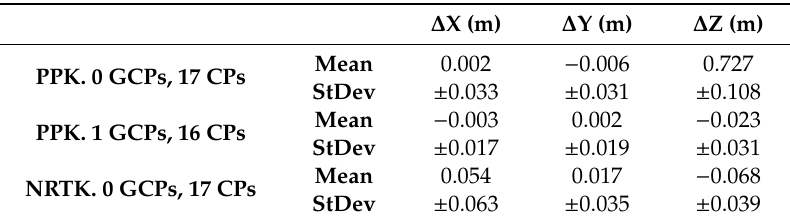
Table 2. Positional accuracy of the di ff erent direct georeferencing strategies tested with the Phantom 4 RTK in the site of Caluso, from [66].